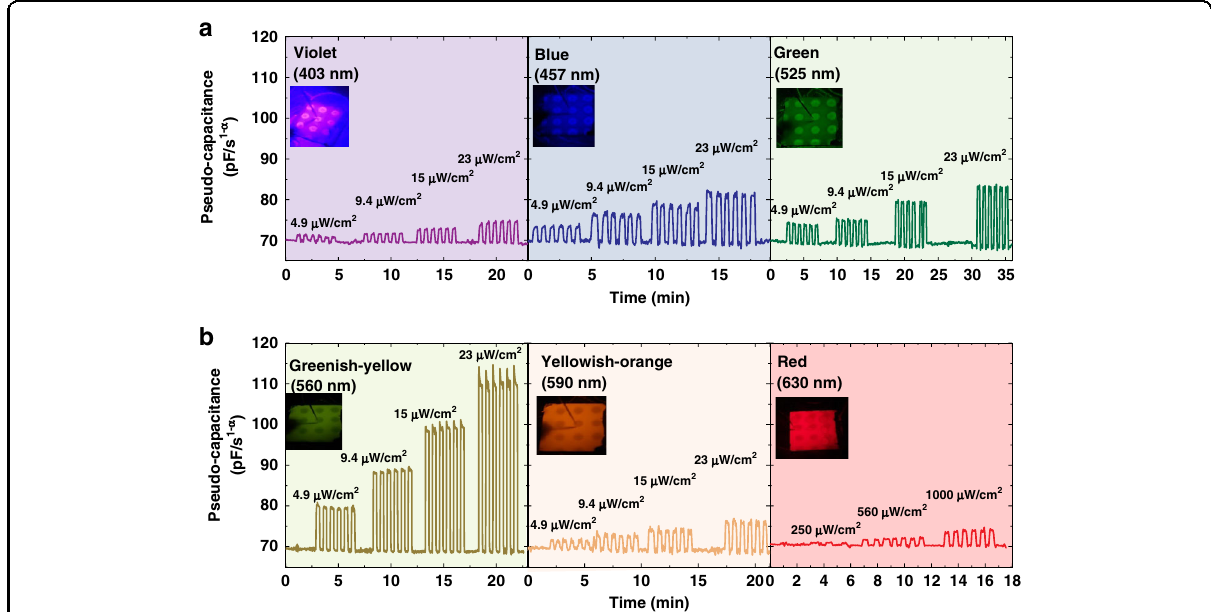
Fig. 4 The transient response of the capacitive photoreceptors (CPRs) under the illumination of LEDs at various intensities, indicating the tunable and reproducible properties of CPRs (measured at 10 kHz). a violet (~ λ peak = 403 nm), blue (~ λ peak = 457 nm), and green (~ λ peak = 525 nm) b greenish-yellow (~ λ peak = 560 nm), yellowish-orange (~ λ peak = 590 nm) and red (~ λ peak = 630